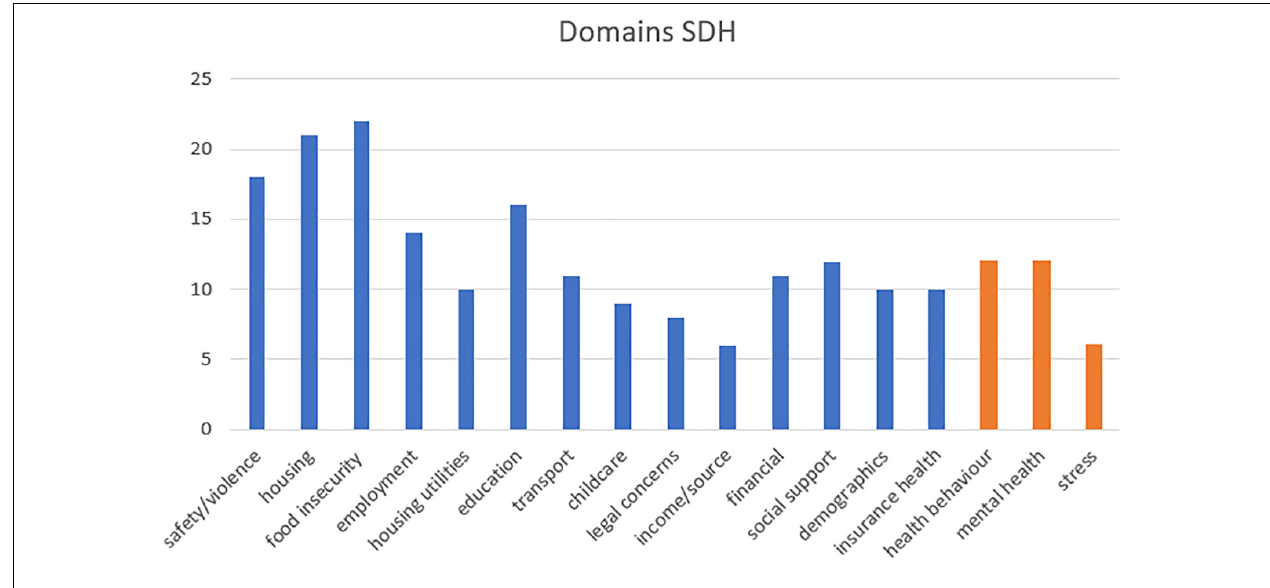
FIGURE 2 | Domains of the Social Determinants of Health.